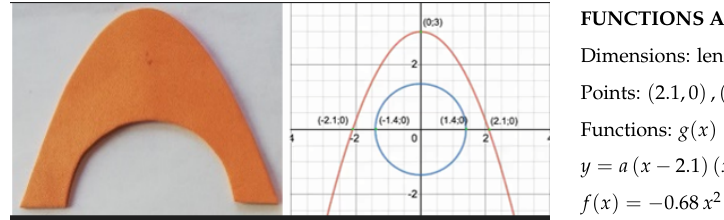
FUNCTIONS AND POINTS Dimensions: length 4.2cm, height 3cm.